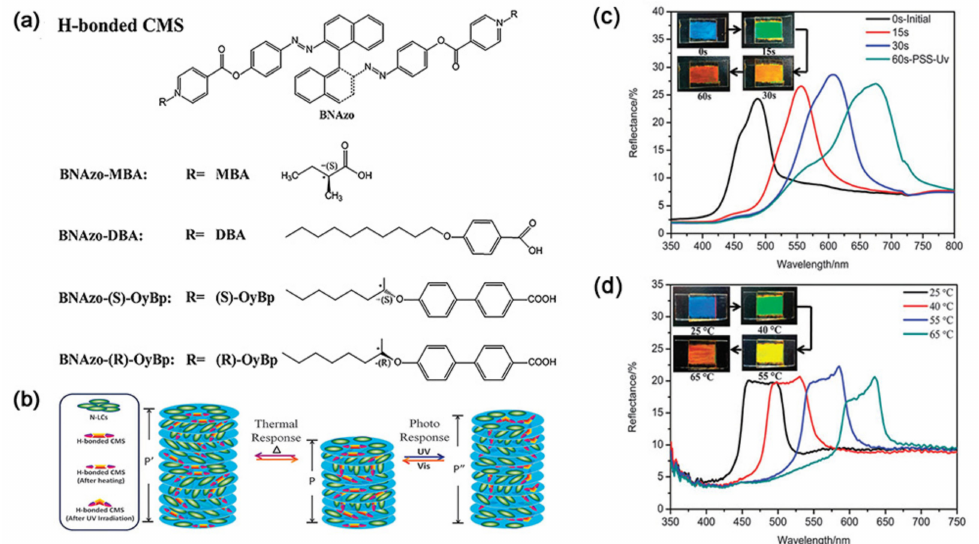
Figure 6. ( a ) Chemical structures of H-bonded chiral molecular switch (CMS) and proton donors. ( b ) Schematic diagram of the helical superstructure and the corresponding switching mechanism of H-bonded CMS in a nematic liquid crystal (NLC) host reversibly tuned by UV/Vis light and heat. The photographs and reflection spectra of 8.1 wt% BNAzo-MBA in SLC1717 in 10 mm thick planar cells under UV irradiation ( c ) and at various temperatures ( d ). Reprinted with permission from reference [123]. Copyright (2015) Royal Society of